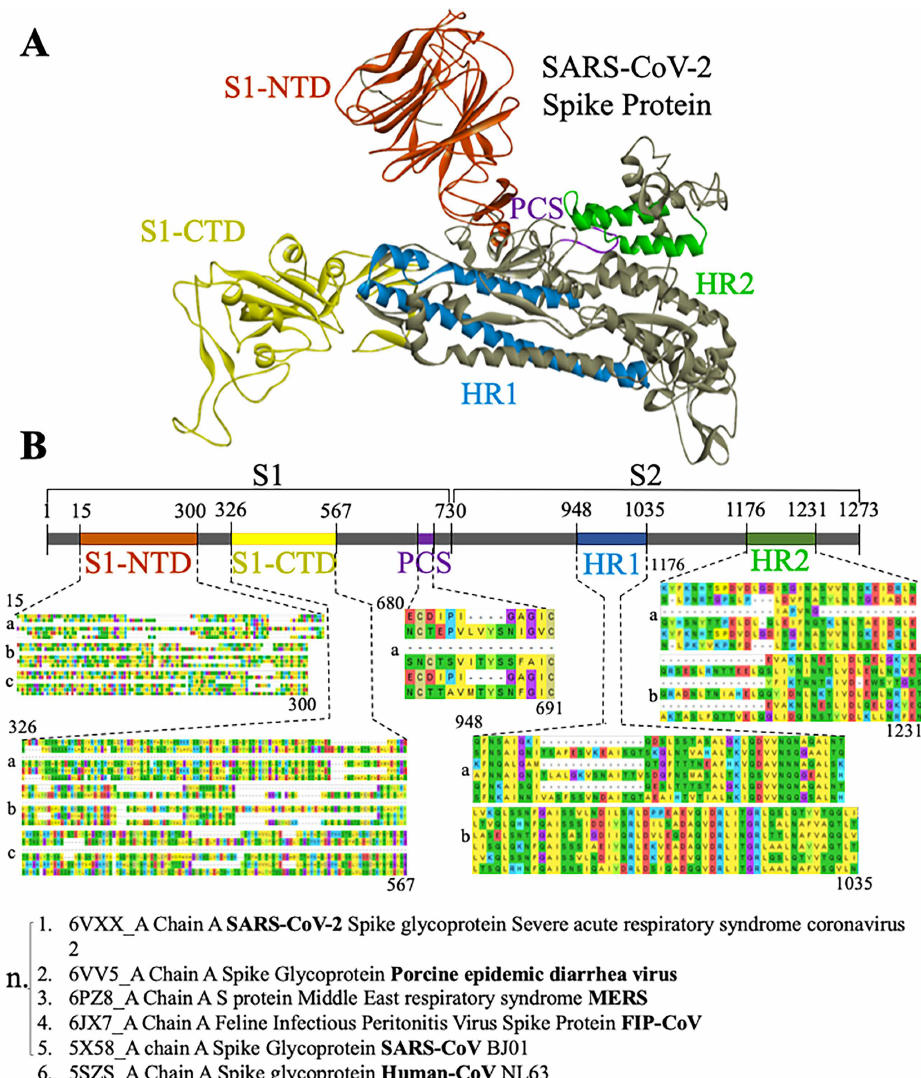
Figure 2. ( A ) SARS-CoV-2 Spike protein 3D structure with the important domains depicted with colors; S1–N Terminal Domain (orange), S1–C Terminal Domain/ ACE2 Binding Domain (yellow), Polybasic Cleavage Site (Purple), S2 Heptad repeat 1 (blue) and S2 heptad repeat 2 (green). ( B ) SARS-CoV-2 Spike protein 2D representation. Important domains are magnified, and their alignment sequences are shown beneath them. Each alignment box consists of 1 to 3 lanes (a, b, c), whereas the starting amino acid is shown at the top left and the ending amino acid is shown at the bottom right of each alignment box. Each lane consists of 6 sequences subjected to the alignment (n). Conservation exists in higher levels at S2-HR1 and HR2, moderate conservation occurs at S1-NTD and PCS, whereas at S1-CTD there are many hyper-variable